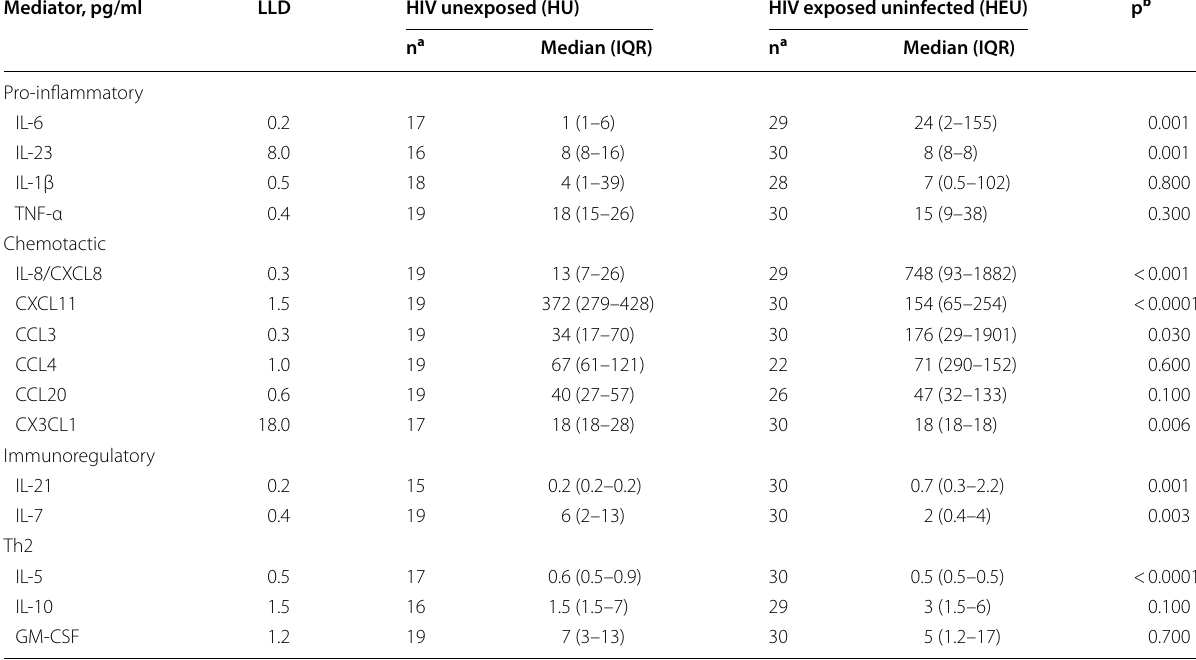
The following cytokines were below the assay limit of detection in both populations: IFNγ, IL‑12(p70), IL‑13, IL‑17α, IL‑2 and IL‑4 LLD lower limit of test kit detection, pg/ml a Number samples with valid results b Bonferroni correction for multiple comparisons was applied; p < 0.003 was considered